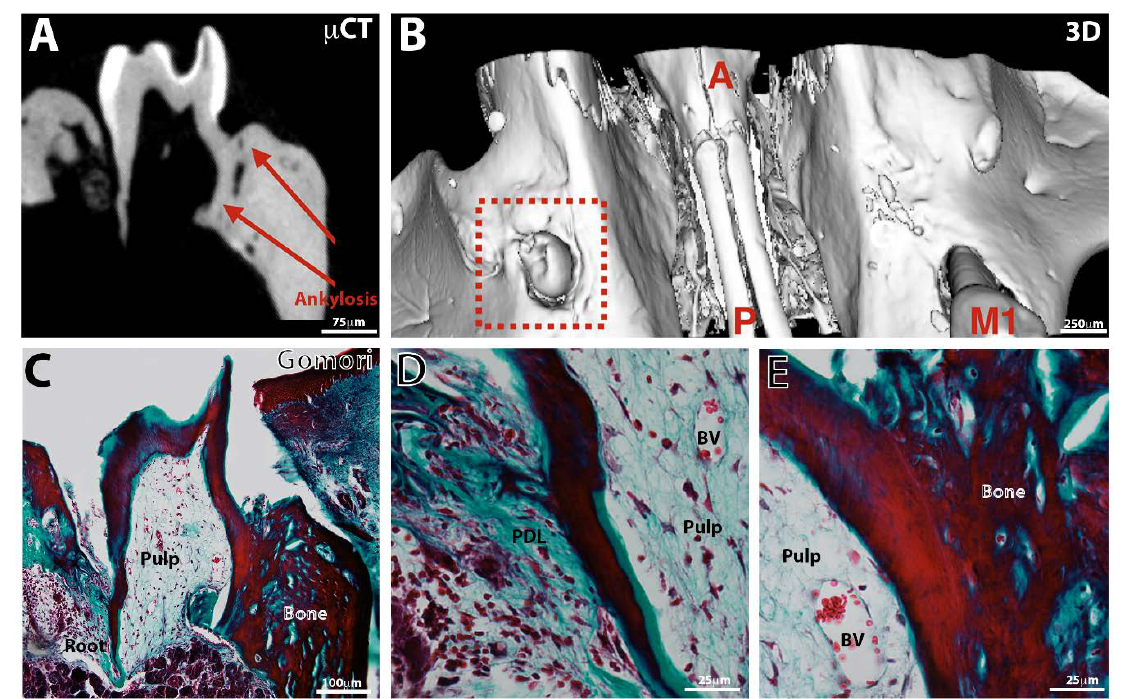
Figure 4. Observation of an ankylosed erupted bioengineered tooth. Microtomography ( µ CT, A ), 3D reconstruction ( B ), and histology ( C – E , Gomori staining) of a bioengineered tooth implanted with a PCL membrane for 10W in the maxillary bone. After 8 weeks of implantation, the different tissues and structures (root, crown, cusps, apical foramen, enamel, dentin, pulp, periodontal ligament) are ( A ) confirmed by histology ( C – E ). Vascularized pulp ( C – E ) and PDL are visible ( D ). Ankylosis is visible. A = anterior, M1 = first upper molar, P = posterior and PDL = periodontal ligament.